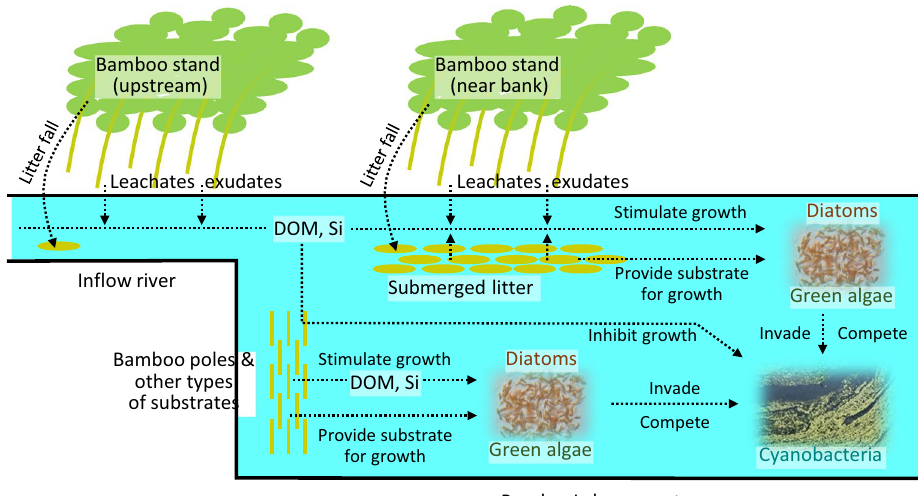
Figure 7. Possible pathways of bamboo control on cyanobacteria. DOM: dissolved organic matter, Si: